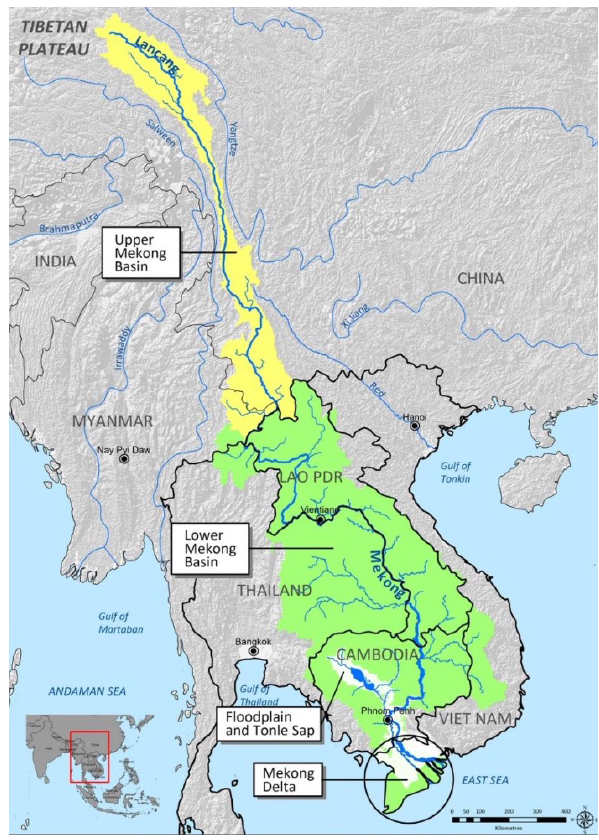
Figure 1. The location of the Lancang–Mekong River, the main river pathway, and its tributaries across the six riparian countries (MRC,